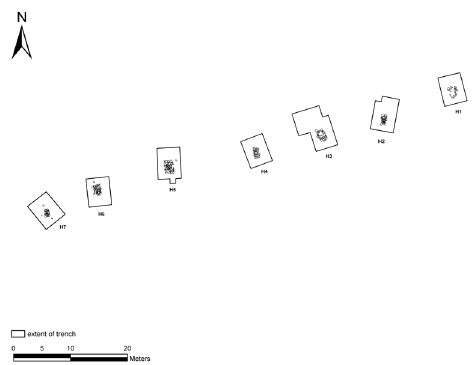
Figure 2a. Site plan of Brodtkorbneset, illustration Radek